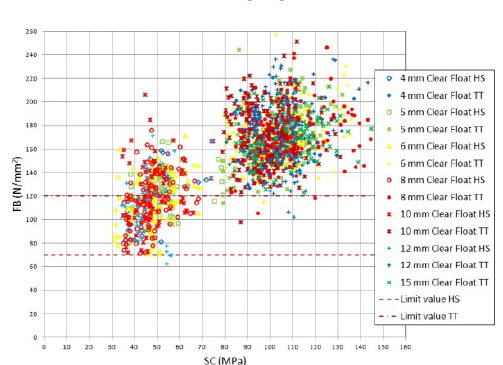
Fig. 5. Correlation of surface compressive stress (SC) versus flexural bending (FB) for float glass.